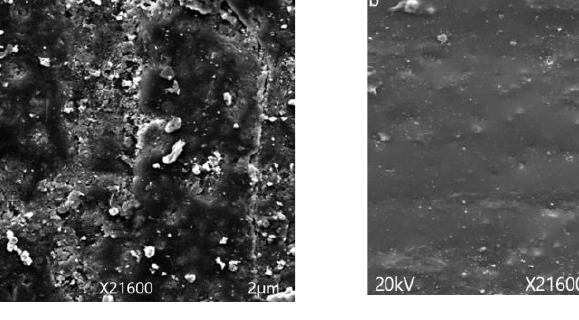
Figure 10. Scanning electron microscopy images of 1000 h aged samples. ( a ) neat epoxy, ( b ) EMC, ( c ) EnC.